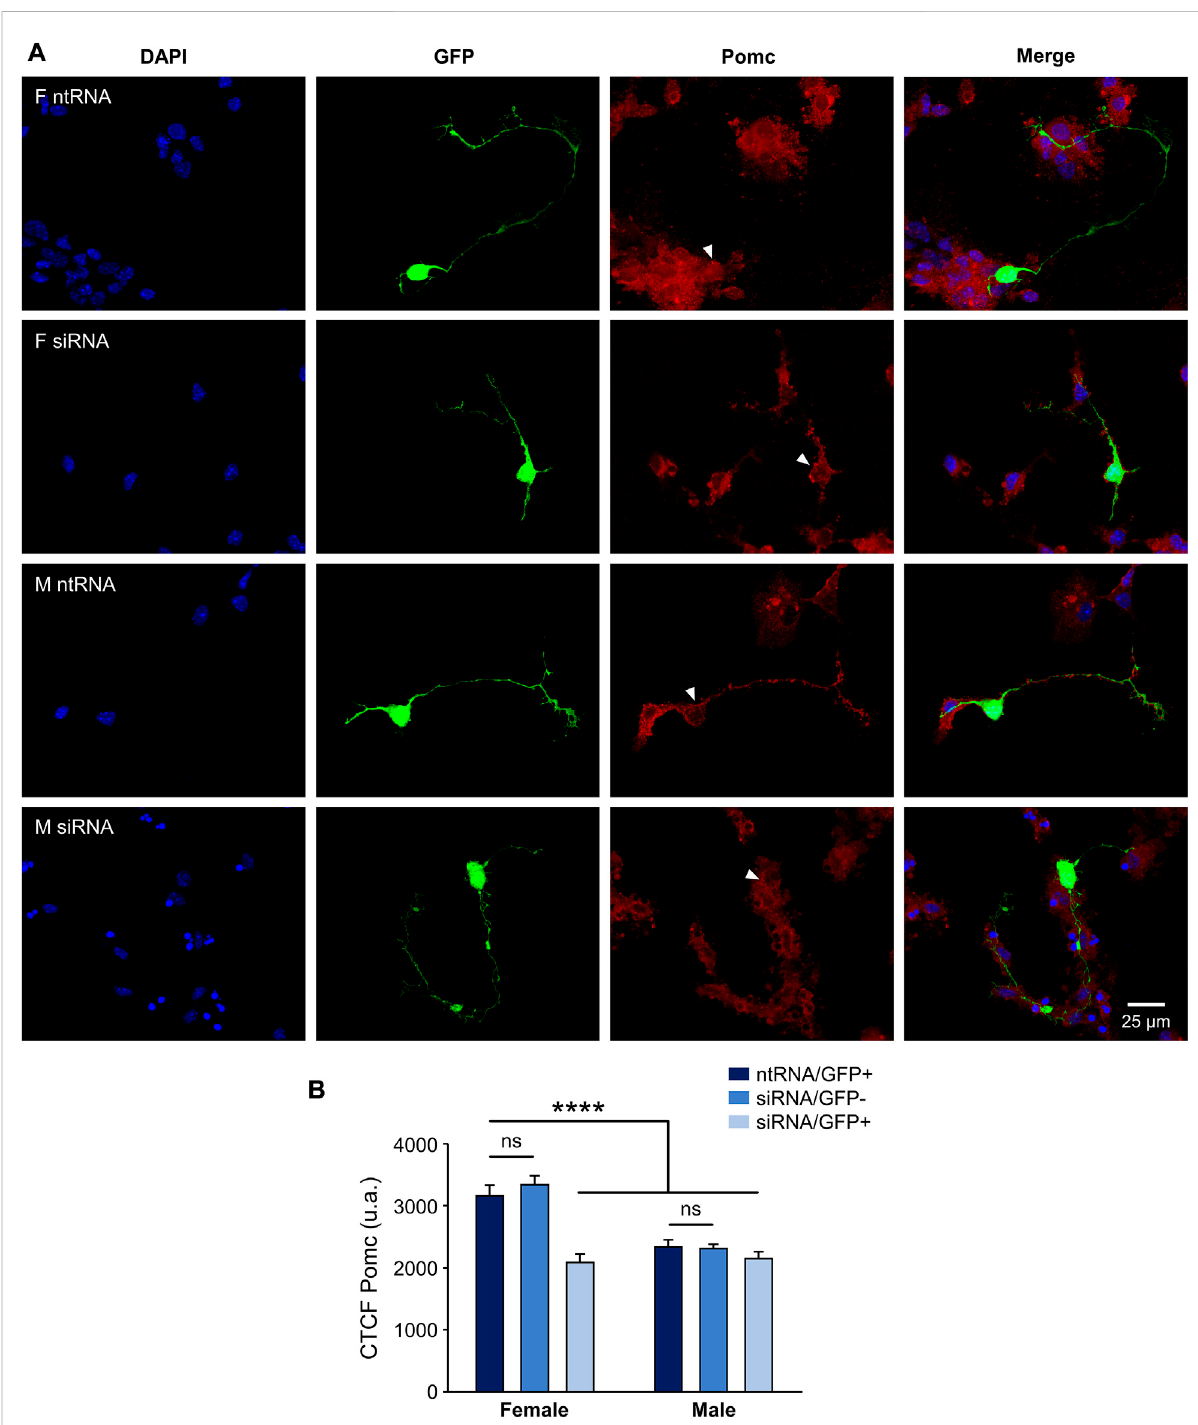
FIGURE 3 Kdm6a is required for Pomc sexually dimorphic expression. (A) Representative fl uorescence images of female (F) and male (M) hypothalamic neurons co-transfected with a non-targeting siRNA sequence (ntRNA) and GFP or siRNA targeting Kdm6a (siRNA) and GFP at three DIV for 18 h. Pomcproteinexpression(red)wasdeterminedbyimmuno fl uorescencestainingintransfectedGFP+neurons(green).NucleiwerestainedwithDAPI (blue). Arrowheads point to representative measured neuronal somas. (B) Quanti fi cation of fl uorescence intensity for Pomc expressed as corrected total cell fl uorescence (CTCF). Kdm6a knockdown by siRNA abolished sex differences in Pomc protein expression by downregulating the neuropeptideonlyinfemale-derivedneurons.Dataaremean±SEM.n=55 – 80neuronsfromfourindependentculturesforeachsexandtreatment. ns, not signi fi cant; **** p <